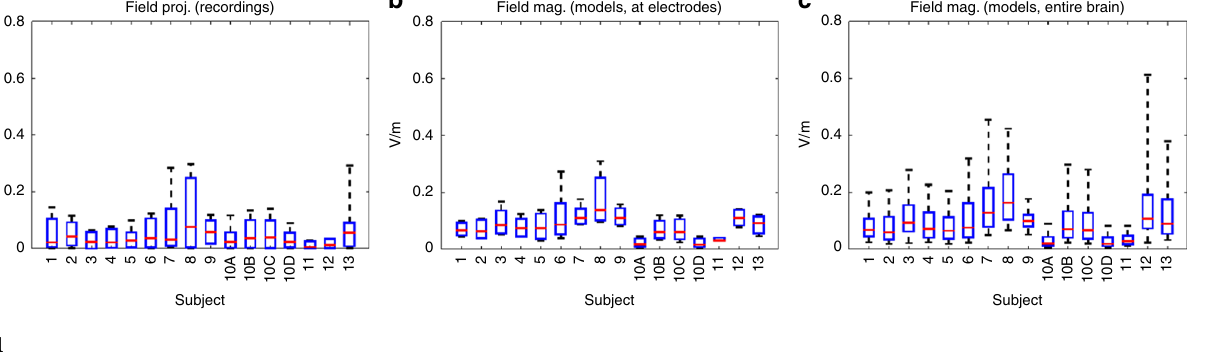
Fpz–Oz, 1 mA (Our config)